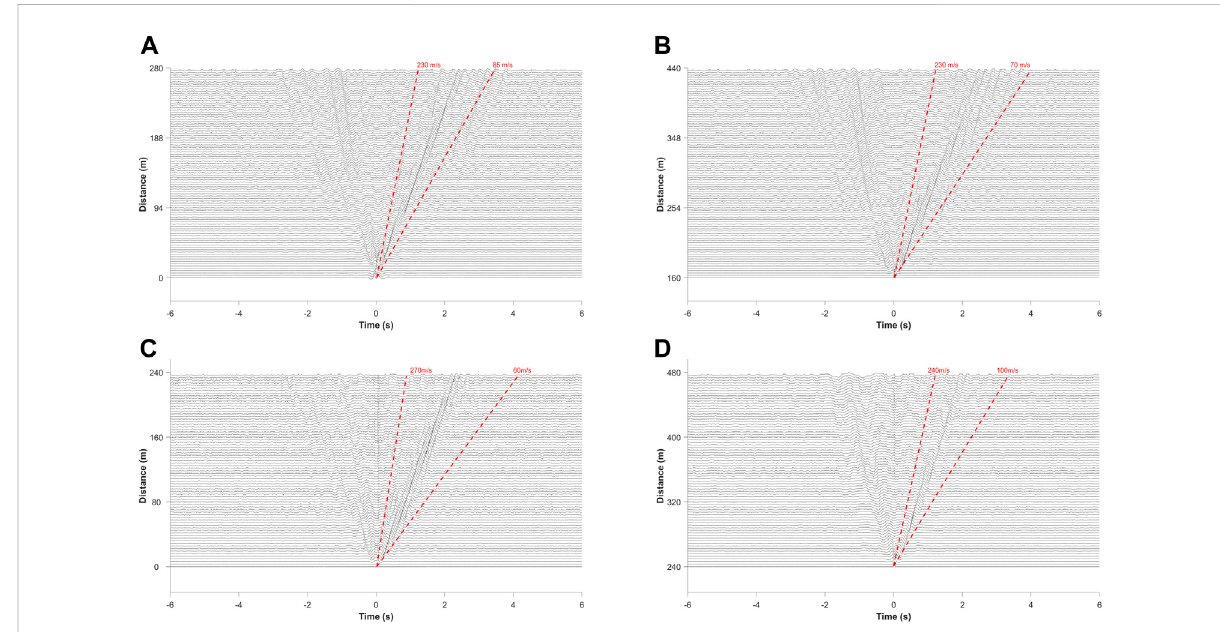
FIGURE 10 NCFsofthevirtualsourceatChannel 11 (A) ,andChannel175 (B) inLineI,andatChannel51 (C) , andChannel 200 (D) inLineII,respectively. The red dashed lines show the apparent